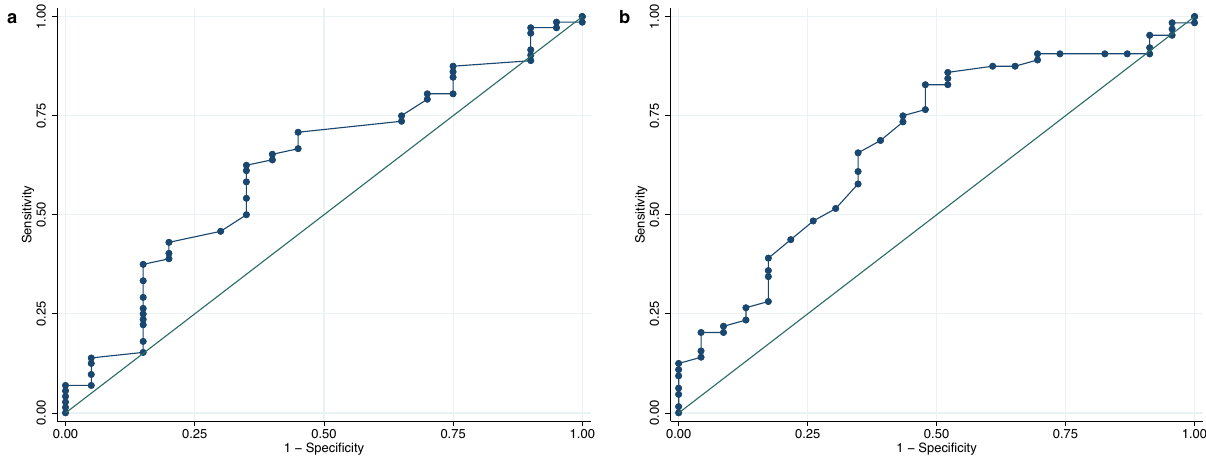
Fig. 5 Receiver-operating characteristic (ROC) curve for pre-school sample. Receiver-operating characteristic (ROC) curve with an area under the curve (AUC) of a 0.62 for children <5 years of age ( n = 92) and b 0.68 for children ≥ 5 years of age ( n = 87) in the pre-school sample. Source data is in Supplementary Data